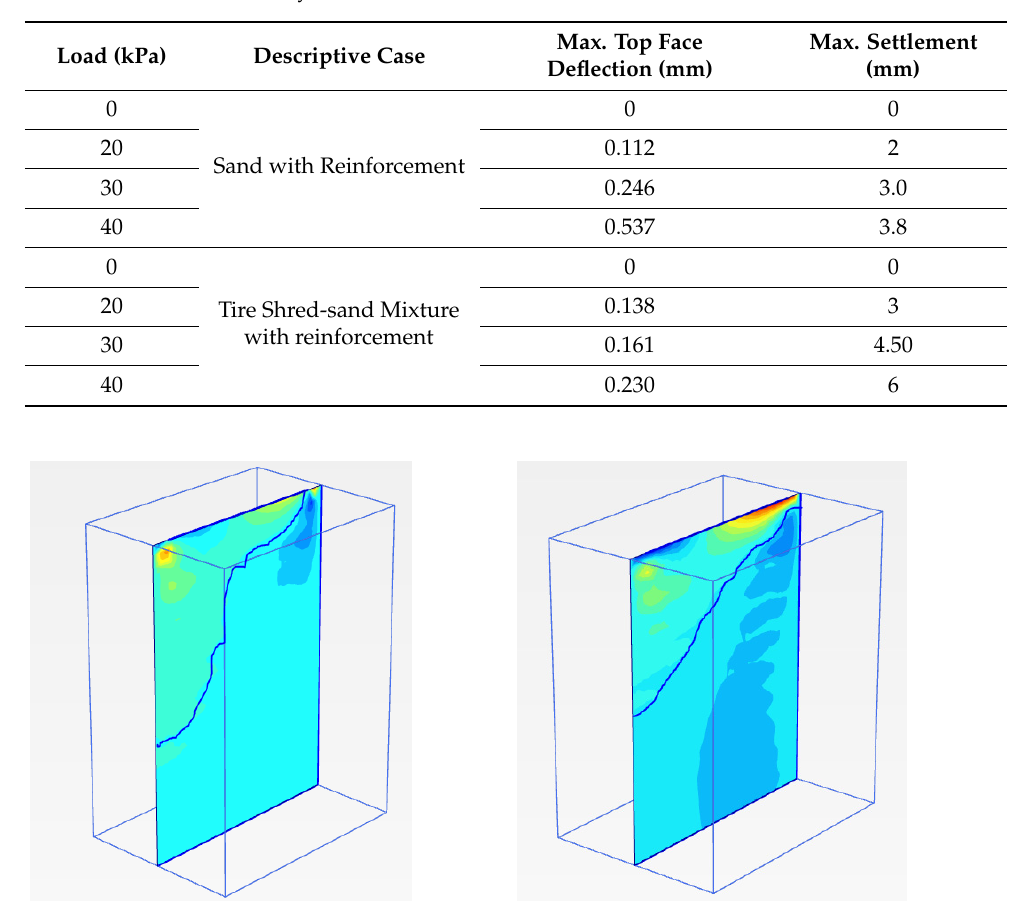
Figure 12. Comparison of face deflection for sand only (0/100) and tire shred-sand mixture (20/80) in Plaxis 3D.